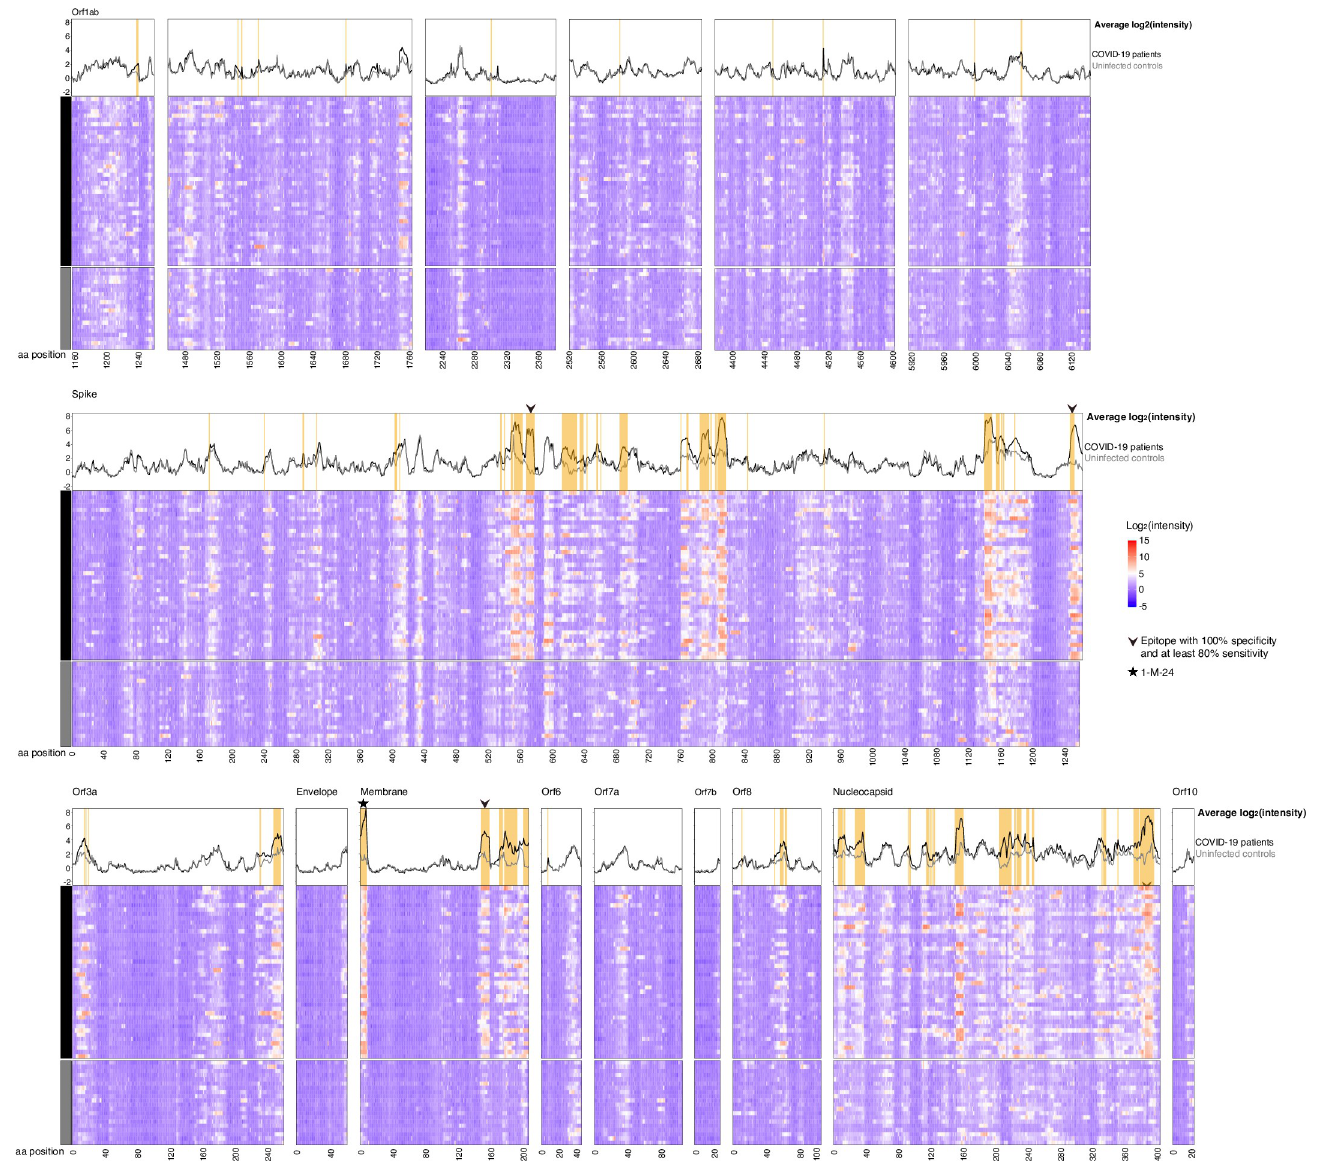
Fig 3. Anti-SARS-CoV-2 antibodies bind throughout the viral proteome. Sera from 40 COVID-19 convalescent patients were assayed for IgG binding to the full SARS-CoV-2 proteome on a peptide microarray. B cell epitopes were defined as peptides in which patients’ average log 2 -normalized intensity (black lines in line plots) is 2-fold greater than controls’ (gray lines in line plots), and t test statistics yield adjusted p -values < 0.1; epitopes are identified by orange shading in the line plots. Epitopes having at least 100% specificity and at least 80% sensitivity for SARS-CoV-2 infection are indicated by a black arrow. The 1-M-24 epitope, which had the highest combined reactivity, specificity, and sensitivity of all epitopes we defined, is indicated by a black star. The data used in this analysis can be accessed online at: https://github.com/Ong-Research/UW_Adult_Covid-19. aa, amino acid; COVID-19, coronavirus disease 2019; IgG, immunoglobulin G; SARS-CoV-2, severe acute respiratory syndrome coronavirus